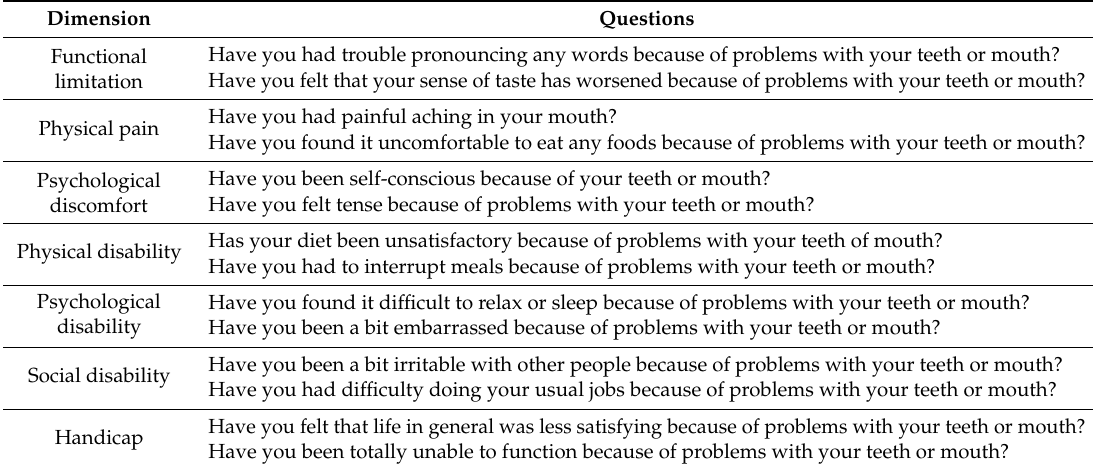
Table 1. Dimensions and questions for the OHIP-14 used in the PELFI cohort, Spain (n = 401).